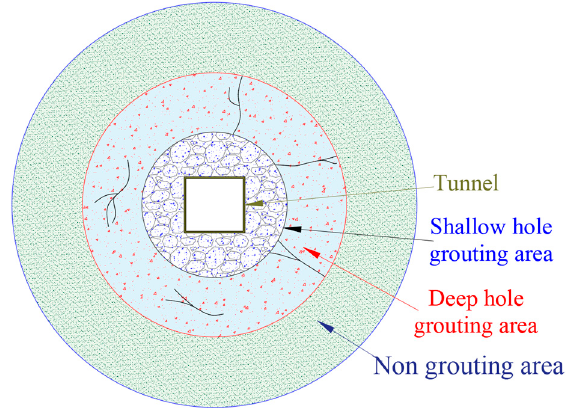
Figure 16. Roadway deformations after roof cutting.